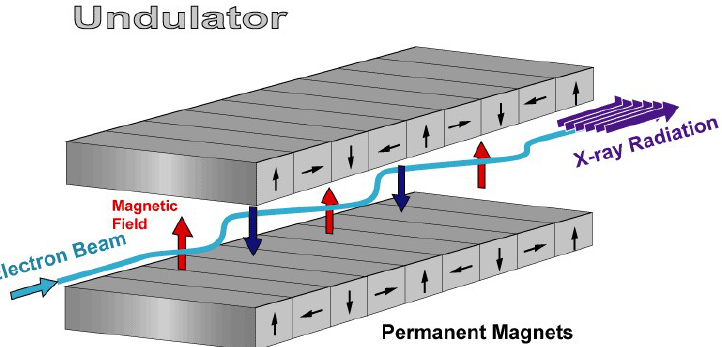
Figure 1. Scheme of free-electron laser. Here the undulator is built by permanent magnets, where the period corresponds to the distance between two red arrows. The electrons wiggle along the undulator axis and emit a radiation burst in the forward